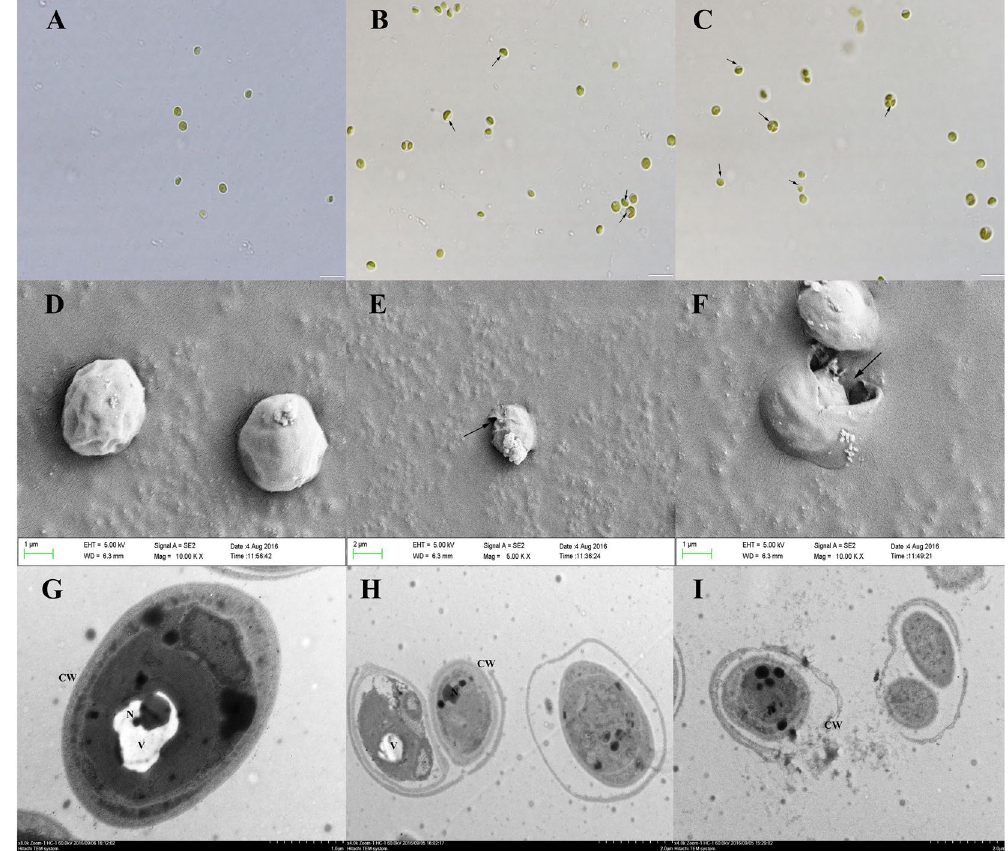
Figure 4. Microstructural and ultramicroscopic structure changes of M. aeruginosa exposure to 4 μ g/mL compound 1 and DBL for 72 h. Light micrographs of Microcystis cells: ( A ) Normal M. aeruginosa cells, scale bar = 20 μ m; ( B ) M. aeruginosa cells exposed to compound 1 , scale bar = 20 μ m; ( C ) M. aeruginosa cells exposed to DBL, the arrows in B and C pointed to the shrinkage and perforation of cell membrane, scale bar = 20 μ m; SEM of Microcystis cells: ( D ) Control M. aeruginosa cells present normal shape, scale bar = 1 μ m; ( E ) M. aeruginosa cells exposed to compound 1 , scale bar = 1 μ m; ( F ) M. aeruginosa cells exposed to DBL, scale bar = 0.5 μ m; TEM of Microcystis cells: ( G ) Control M. aeruginosa cells present normal shape and structure, CW: cell wall, V: vesicles, N: nucleus, scale bar = 1.0 μ m; ( H ) M. aeruginosa cells exposed to compound 1 , scale bar = 2.0 μ m ( I ) M. aeruginosa cells exposed to DBL, scale bar = 2.0 μ m. Experiments were performed in